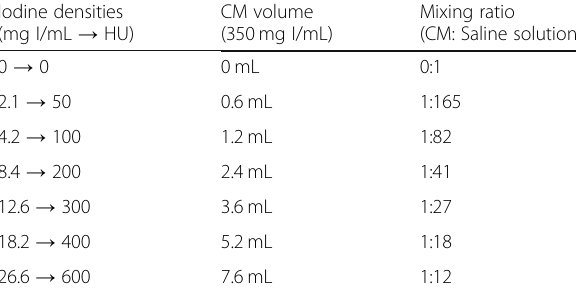
Table 2 Details of the computed tomography scanning